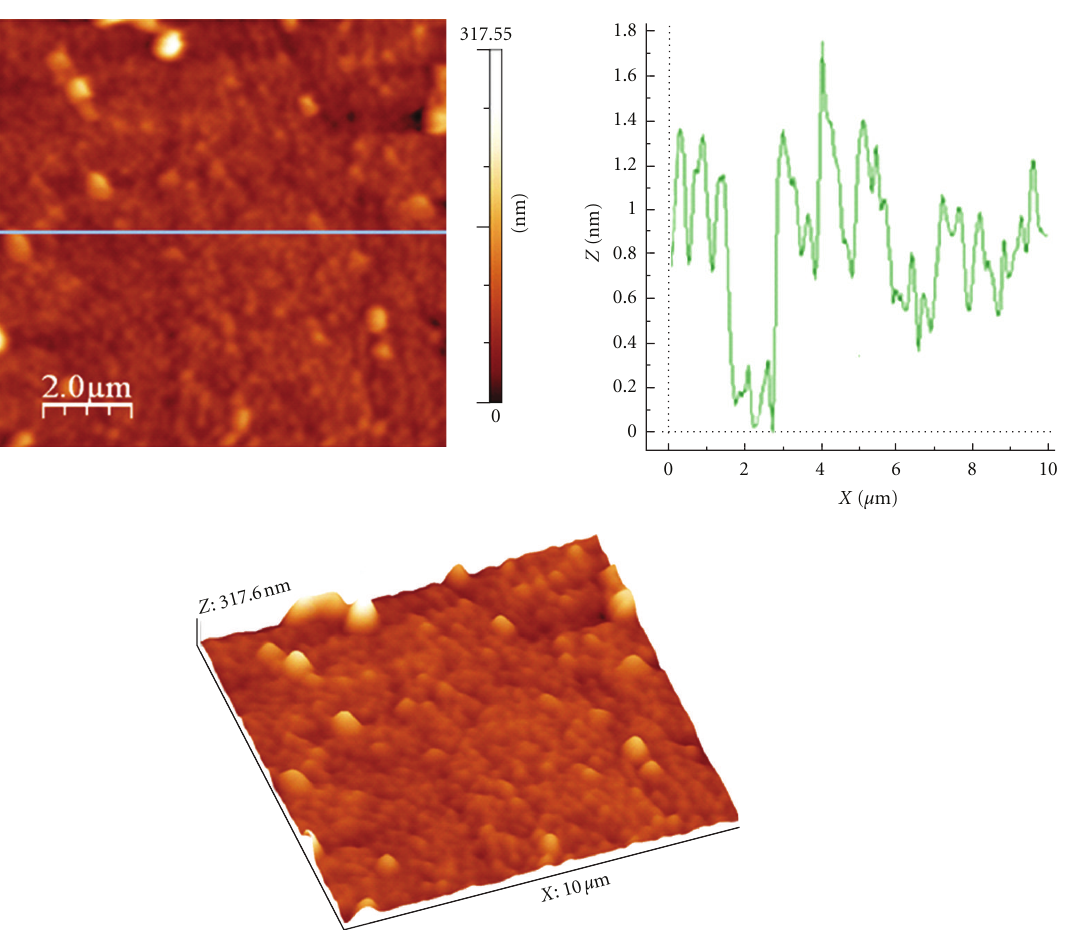
Figure 10: AFM images (2D and 3D) and the section profile of the thin layer of poly(AnPS- co -An) deposited on the Pt electrode surface by cyclic